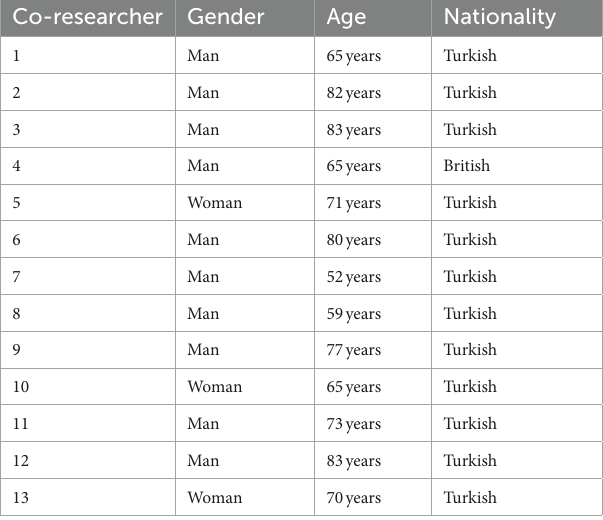
TABLE 2 Demographic characteristics of co-researchers ( N =